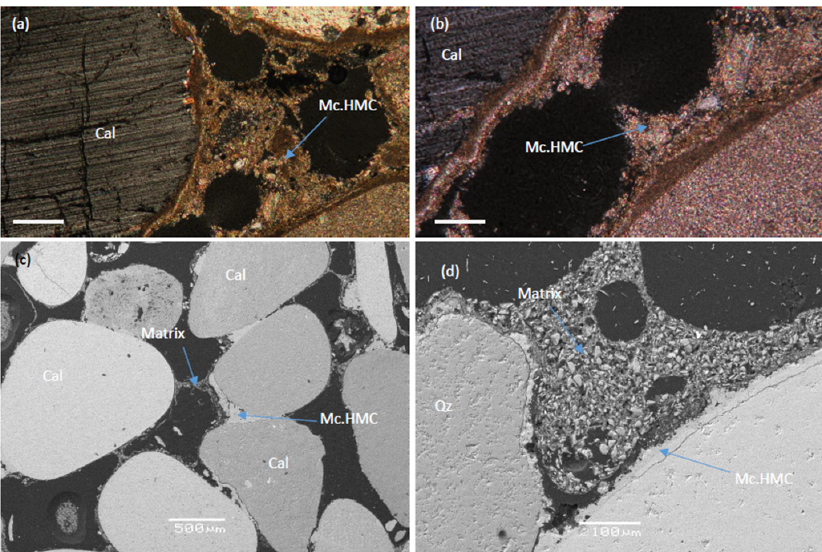
Figure 3. Polarized microscopy image: ( a ) sample Kodi2, 10x magnification, scale 20 μ m. Micritic HMC cement is coating calcite grains; ( b ) sample Kodi2, 20x magnification, scale 10 μ m. Micritic HMC cement is coating calcite grains. SEM images: ( c ) sample Kodi 6, micritic cement is coating calcite grains, the matrix consists of very fine sedimentary particles; ( d ) sample Kodi6, micritic cement is coating calcite and quartz grains, while the matrix consists of very fine sedimentary particles and micritic HMC cement.